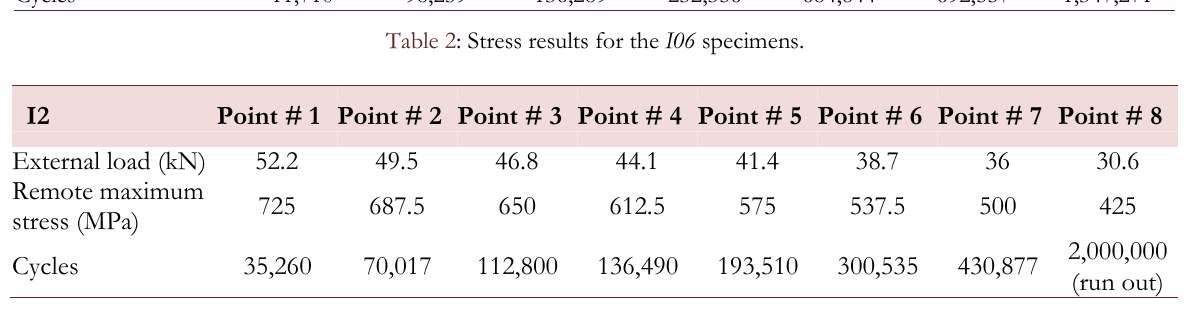
Table 3: Stress results for the I2 specimens.